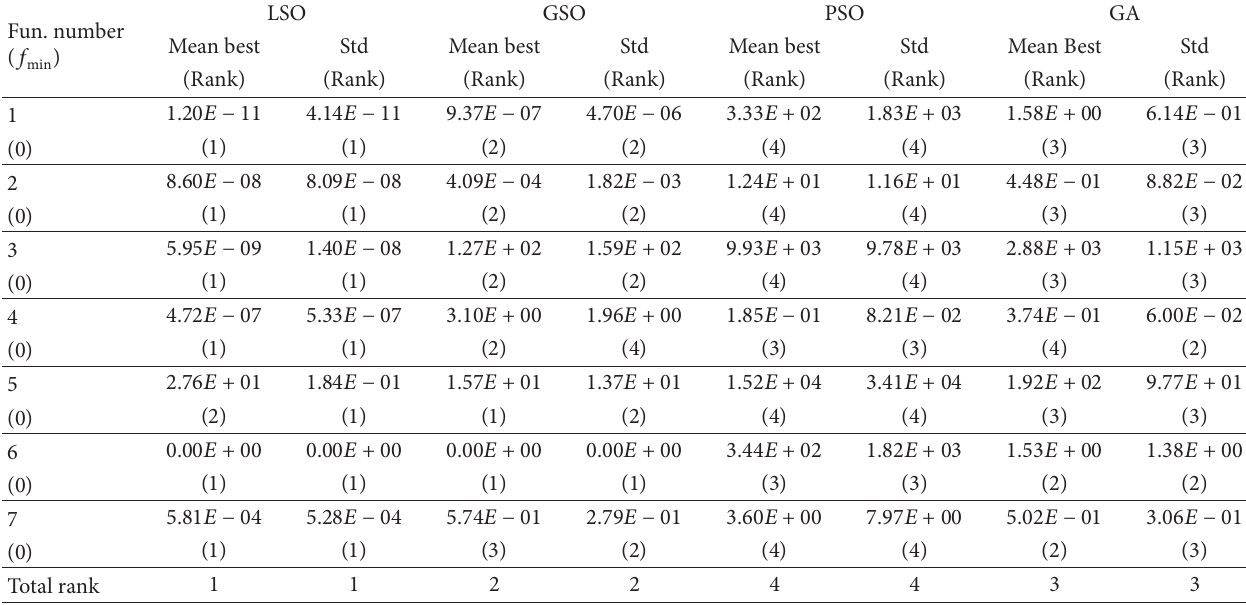
Table 1: Results for all algorithms on benchmarks functions 𝑓 𝑙 to 𝑓 7